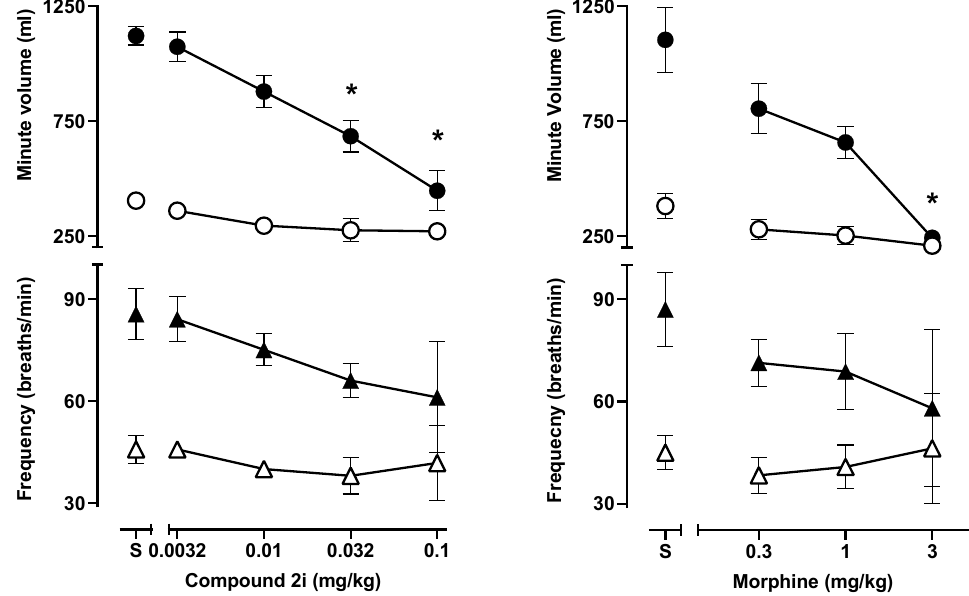
Figure 5. E ff ects in squirrel monkeys of 2i and morphine on respiratory rate (bottom panels) or on